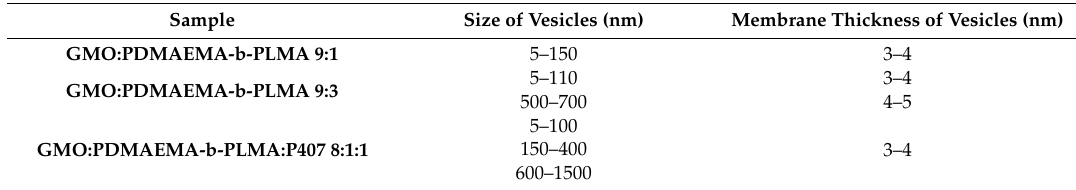
Table 5. Size and morphological characteristics of the existing vesicles of the GMO prepared systems, acquired by